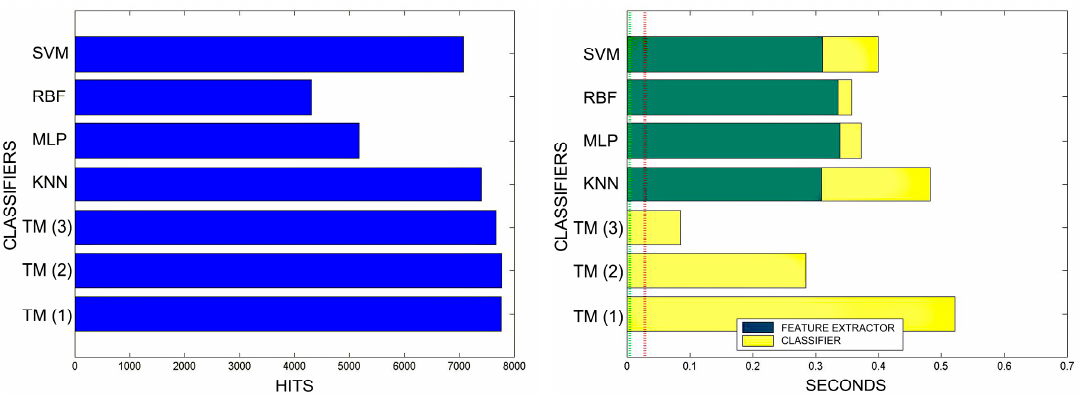
Figure 18. Comparison of successful matches on the left, in blue, and time taken for classification on the right, feature extractor in green, and classification in yellow. In descending order, the training sets represent 0.1%, 1%, 5% of the total training samples.